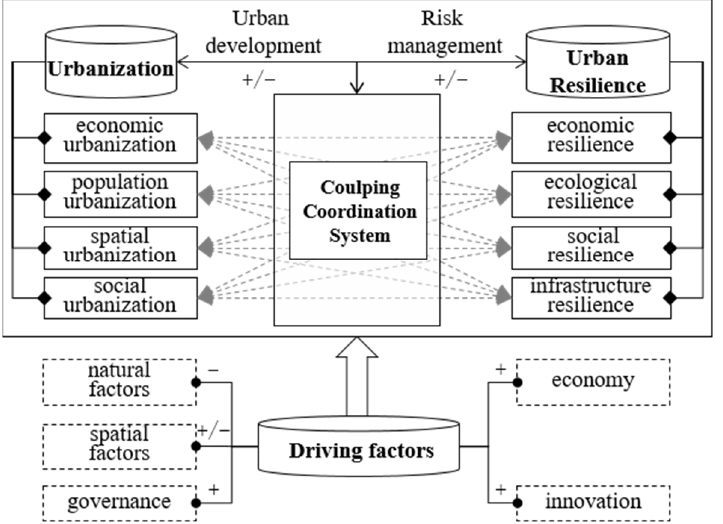
Figure 1. The relationship framework between urbanization and urban resilience. “+” means promote, “ − ” means restrain, while “+/ − ” means promote or restrain.